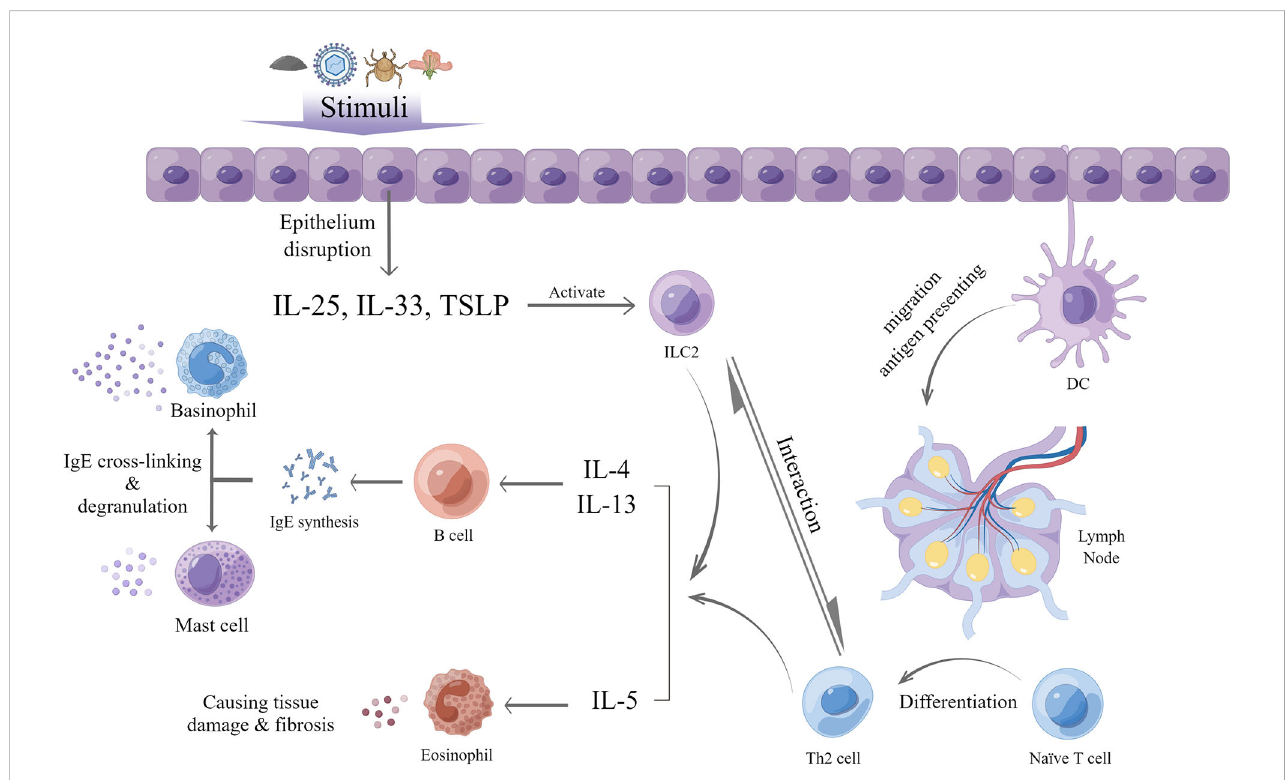
FIGURE 1 General process of type 2 in fl ammation (by